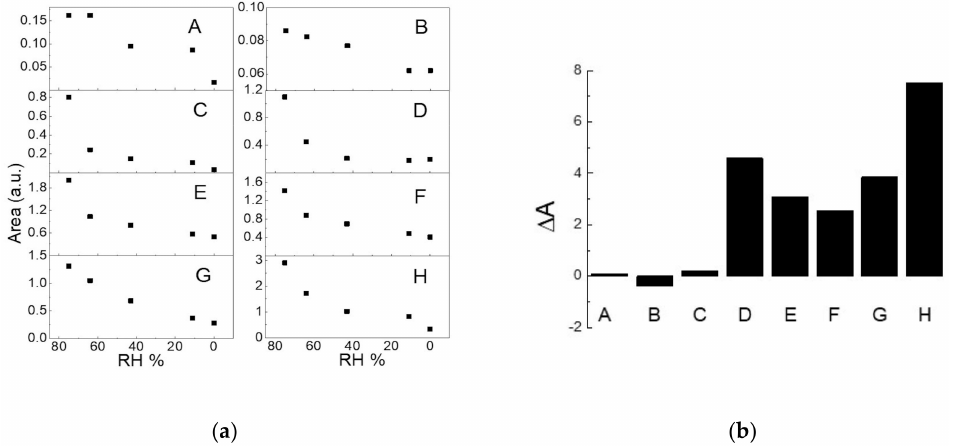
Figure 3. DMPC/H 2 O samples. ( a ) Dependence of the areas of the eight Gaussian band compo- nents on the relative humidity. Each panel corresponds to a different band, as named in Table 2. ( b ) Fractional variation of the area of each band evaluated as (I75% − Idry)/Idry. By calculating the fractional variation of the area of each band in the wet state